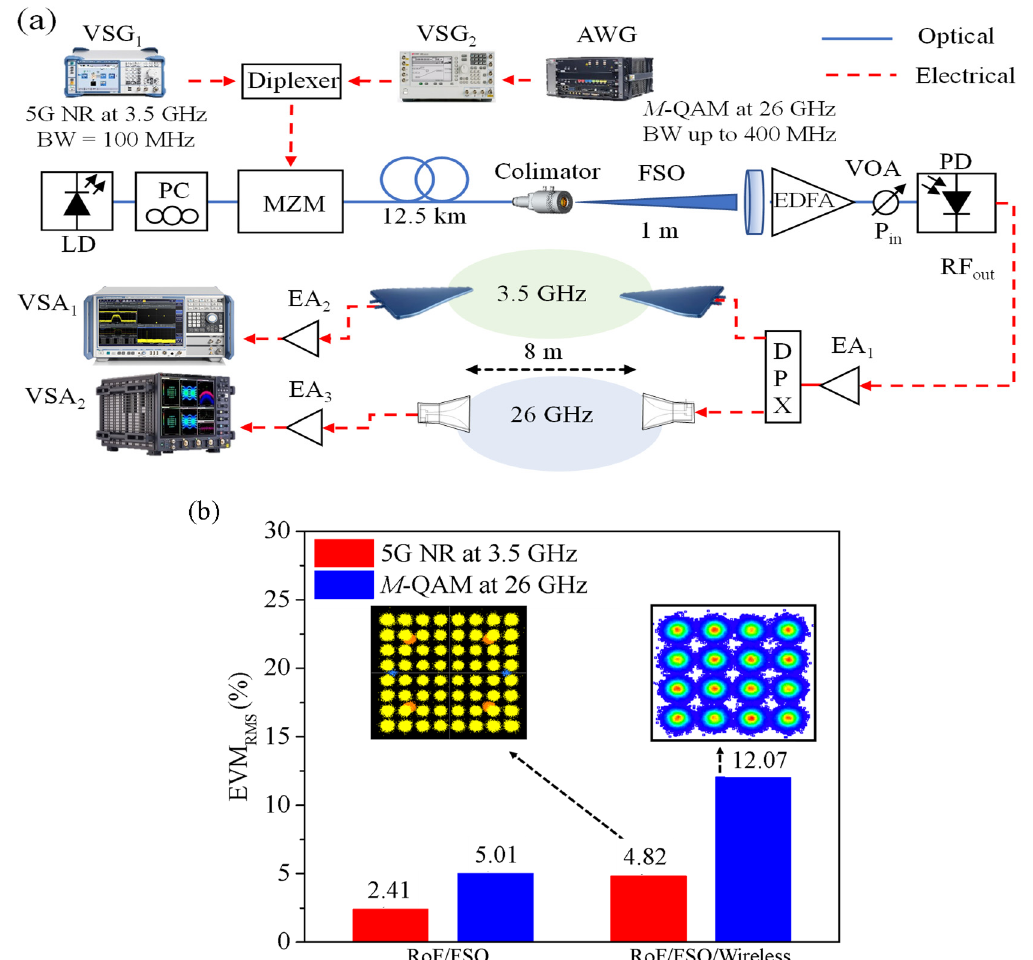
Figure 4. Combined fiber-optic and FSO-based 5G fronthaul architecture. ( a ) Block diagram; ( b ) performance analysis of 5G NR and M -QAM signals in the optical-wireless system. The constellations from the RoF/FSO/wireless approach show 16- and 64-QAM received symbols suitable for demodulation.